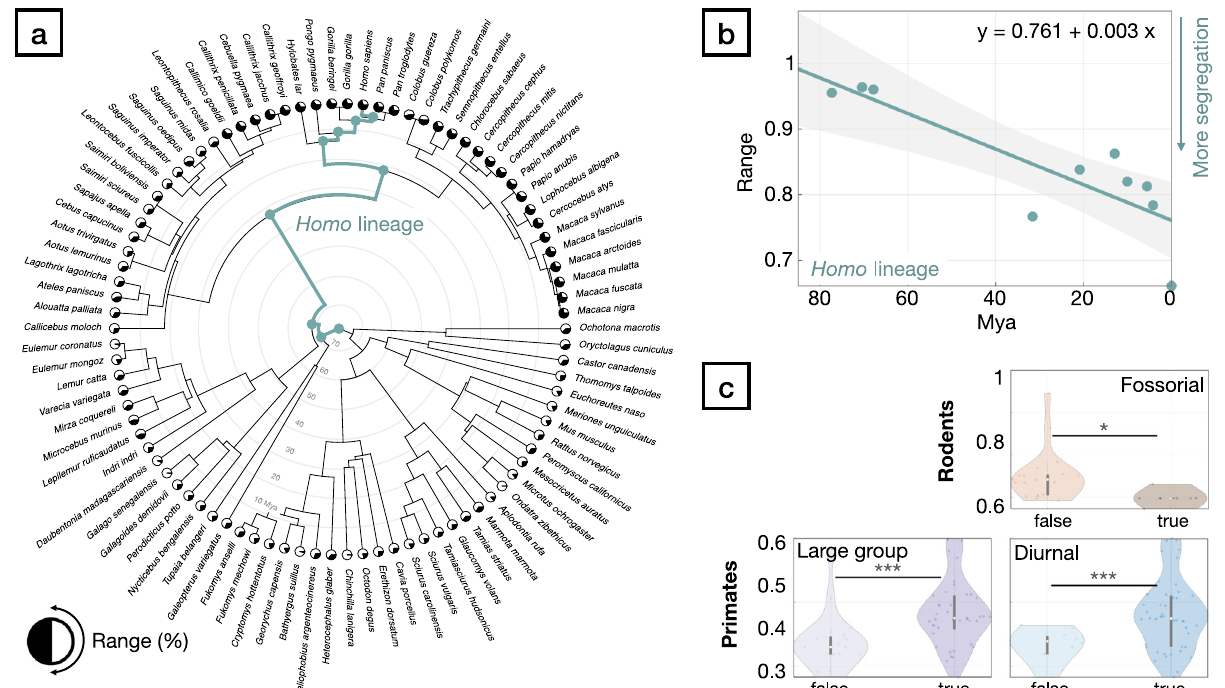
Fig. 6 | Segregation of primary sensory cortical areas during evolution. Map- ping of species-speci fi c cytoarchitectonic atlases allows for the determination of the functional topography of cortical regions and the relationship of the relative positioning of functional cortical areas and species ecology. a Spatial statistics indicate an evolutionary segregation of primary sensory cortical areas in the deep ancestral human lineage (green path), with a ( b ) signi fi cant positive relationship between the integration of sensory areas and evolutionary time (r(8)=0.714, p =0.002, shaded area indicates the 95% con fi dence interval of the linear model. See also Supplementary Data 6b). c Violin plots of the values for range parameters of the spatial statistics model for fossorial and non-fossorial rodents as well as